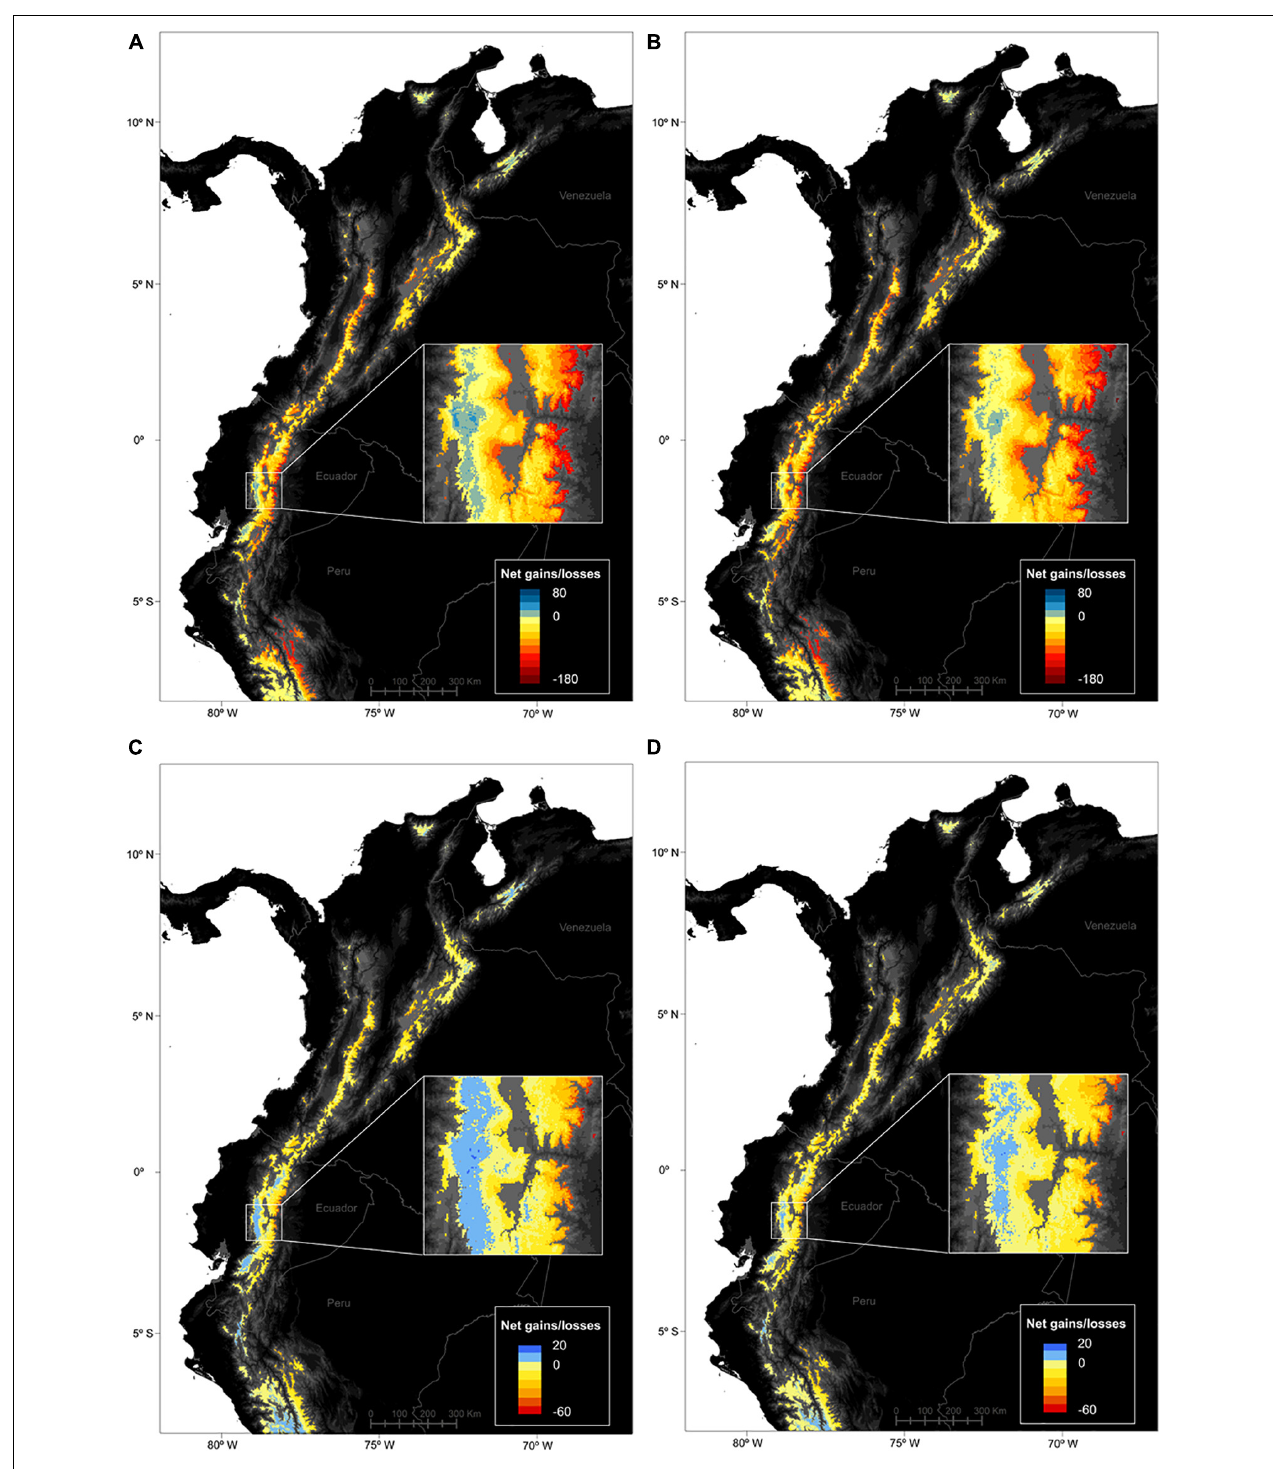
FIGURE 3 | Predicted spatial patterns of net distribution gains and losses for vascular plant species in the páramo region between 2010 and 2070, according to two climate change scenarios, (A,C) RCP45 – the moderate scenario, and (B,D) RCP85 – the severe scenario. A raster cell value accounts for the number of species predicted to have occupied the cell in 2010 and/or 2070, as well as the species-specific responses in the cell (either positive, stable/gained area, or negative, lost area) and averaged across the 5 GCMs considered. (A,B) were computed on the complete species pool (664 species), while (C,D) were computed on the endemics pool only (247